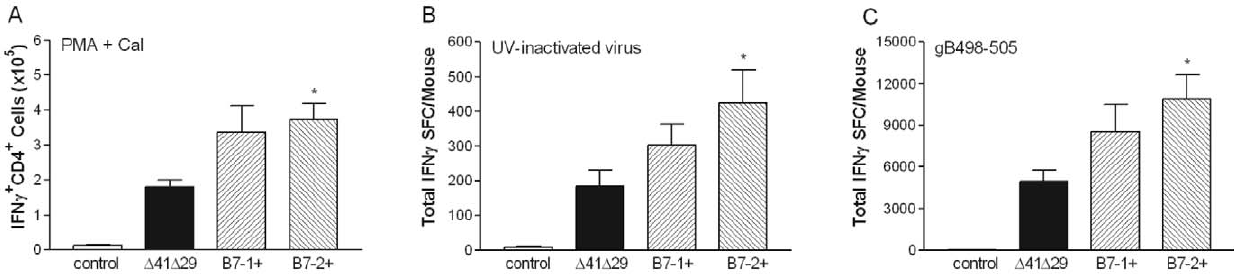
Figure 2. IFN c -producing T cells induced by immunization. Groups of mice were immunized with 4 6 10 5 pfu of the indicated replication- defective virus or control supernatant. Six days after immunization cells from the draining lymph nodes were isolated. A) Lymph node cells from BALB/c mice were stimulated with PMA and CaI, then were stained with antibodies to CD3 and CD4, permeabilized and stained with anti-IFN c and analyzed by flow cytometry. Data represent the arithmetic mean 6 SEM of the absolute number of CD4 + IFN c + cells per mouse. B) Lymph node cells from BALB/c mice were stimulated in vitro with UV-inactivated HSV-1 and analyzed in an IFN c ELISpot assay. C) Lymph node cells from BALB.B mice were stimulated in vitro with 0.2 m M of peptide representing the CD8 epitope gB498–505 and analyzed in an IFN c ELISpot assay. Data represent the arithmetic mean 6 SEM of the absolute number of IFN c -producing cells per mouse. Data were compiled from 3 independent experiments for each of panels A, B and C. For each set of 3 experiments the total number of mice used was 4 to 9 mice for the control group, and 11 to 12 mice for each vaccine group. *, P , 0.05 for D 41 D 29 compared with D 41 D 29B7-2.